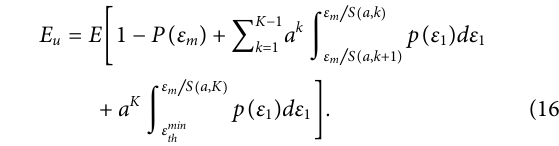
Frontiers in Physics |